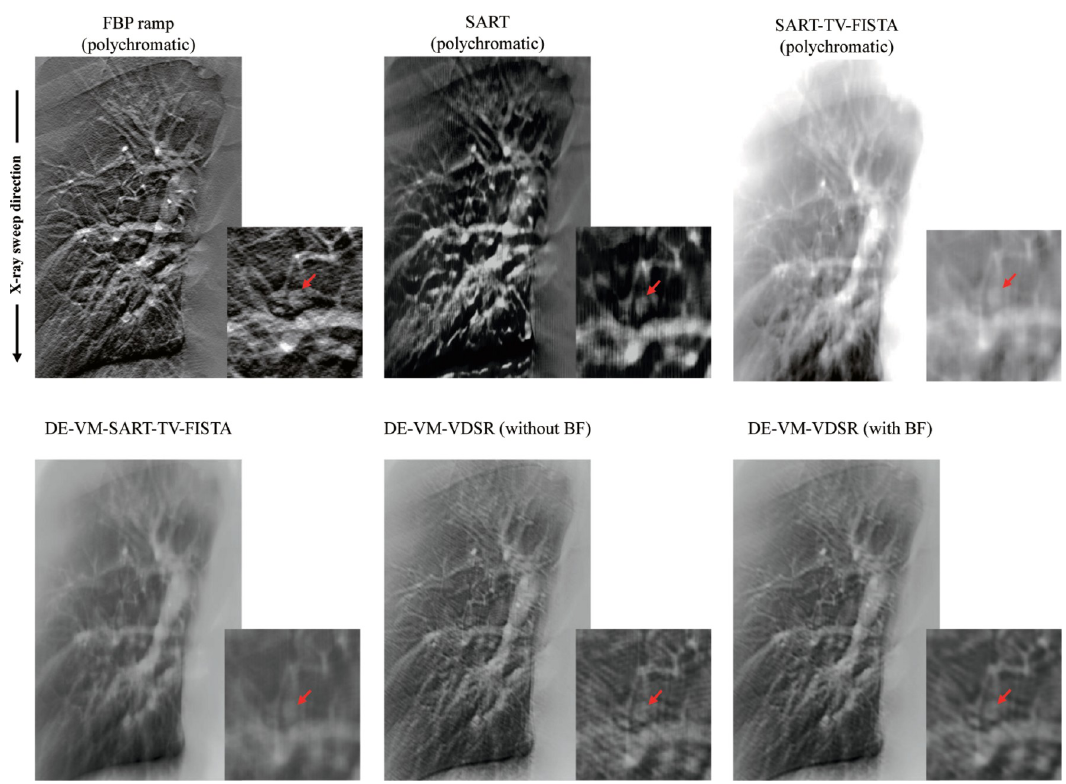
Fig 9. Comparisons among the Dual-Energy (DE) Virtual Monochromatic (VM) with Very-Deep Super-Resolution (VDSR) reconstruction algorithm (DE–VM–VDSR) with and without BF and conventional reconstruction algorithms [DE–VM–VDSR with and without BF (showing window: 0–0.23), FBP (kernel: Ramp; 0–0.4), SART (120 kV; 0–0.02), SART–TV–FISTA (120 kV; 0–0.4), and DE–VM–SART–TV–FISTA (60 keV; 0–0.23)] in the in-focus plane. The window of the chest phantom N1 with lung field was varied to compare the contrast and background gray levels. For each corresponding set, the VM (DE–VM–VDSR and DE–VM–SART–TV–FISTA) images are displayed at the same window width and level, whereas the polychromatic FBP and IR images have larger window widths because the backgrounds are less flattened. The X-ray source is moved vertically along the image. Abbreviations: FBP = filtered backprojection, SART = simultaneous algebraic reconstruction technique, TV–FISTA = total-variation first-iterative shrinkage–thresholding algorithm, IR = iterative reconstruction, BF = bilateral